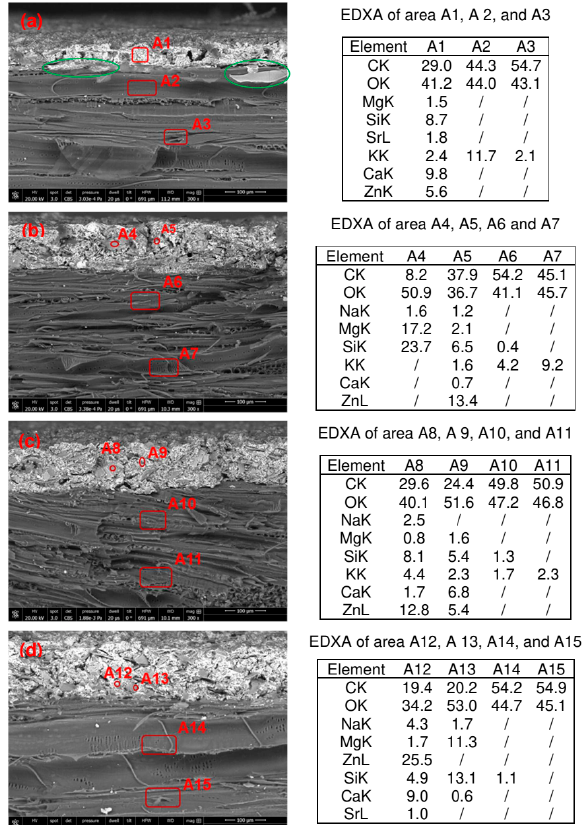
Figure 2. SEM-Energy-Dispersive Analysis of X-rays (EDAX) interfacial analyses of beech wood coated with ( a ) CF1 ( b ) CF2 ( c ) CF3 and ( d ) CF11.